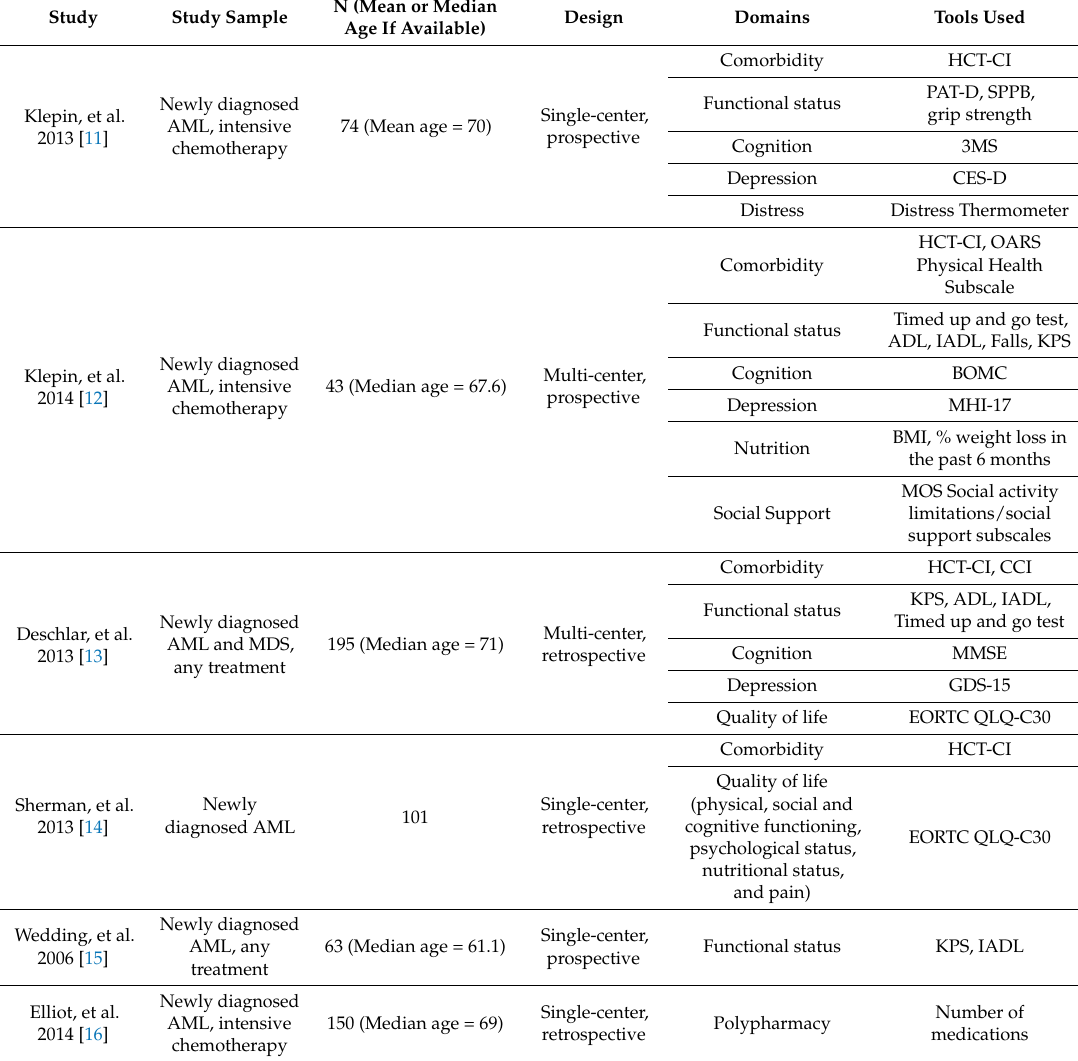
Geriatric domains assessed and tools used in studies of older patients with acute myeloid